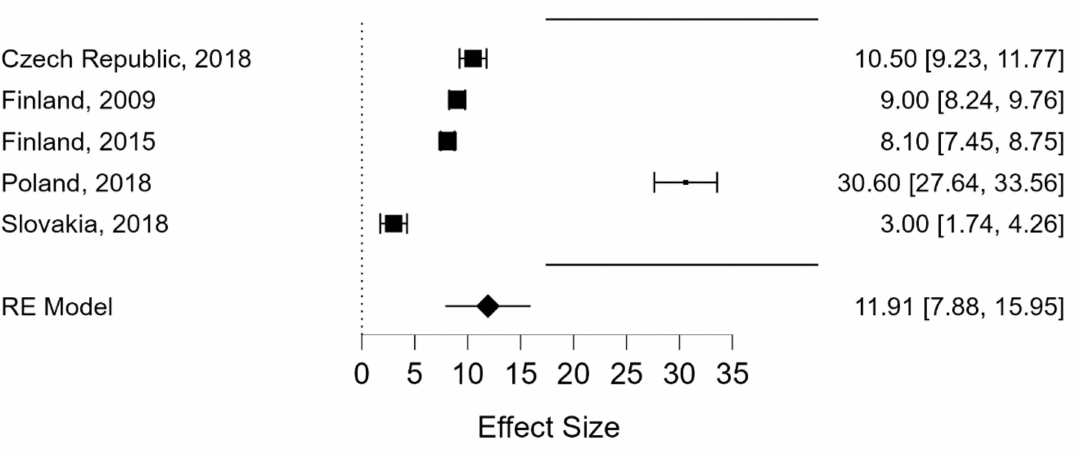
Figure 3. Prevalence estimates of Cyberperpetration in member countries of the European